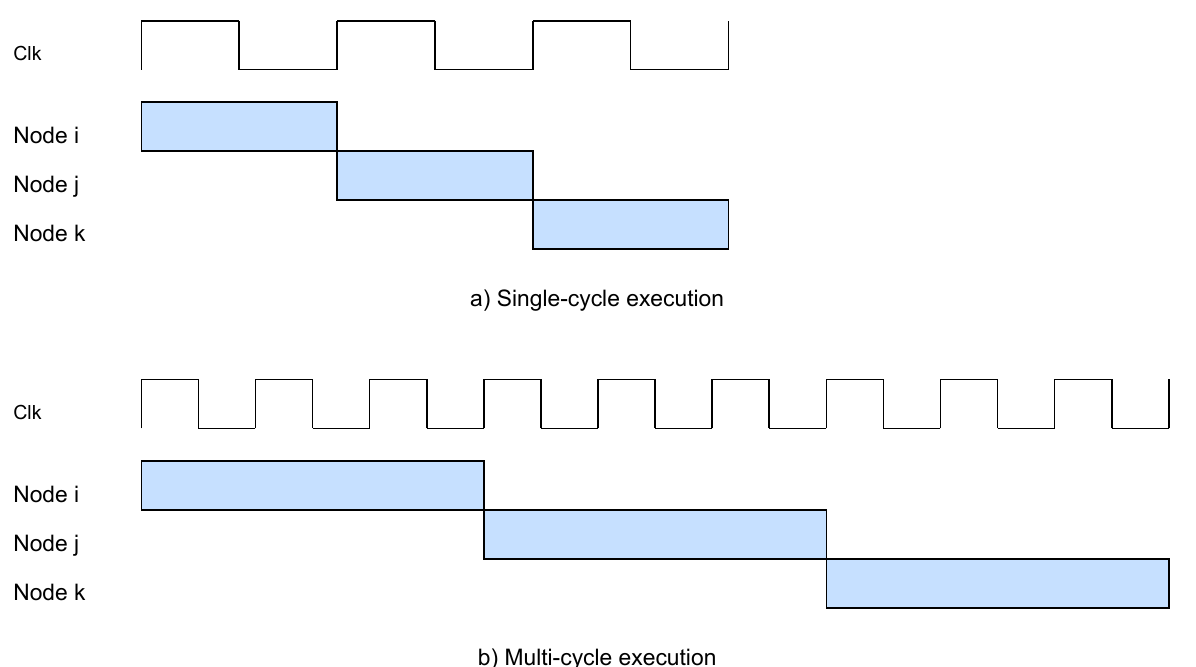
Figure 7. ( a ) Single-cycle execution scheme. ( b ) Multi-cycle execution